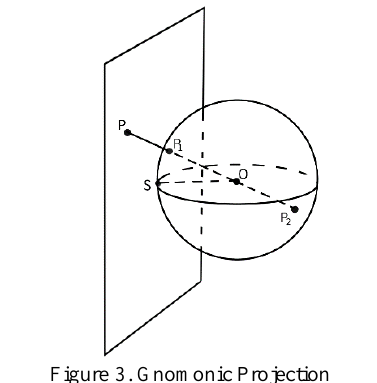
Figure 3. Gnomonic Projection